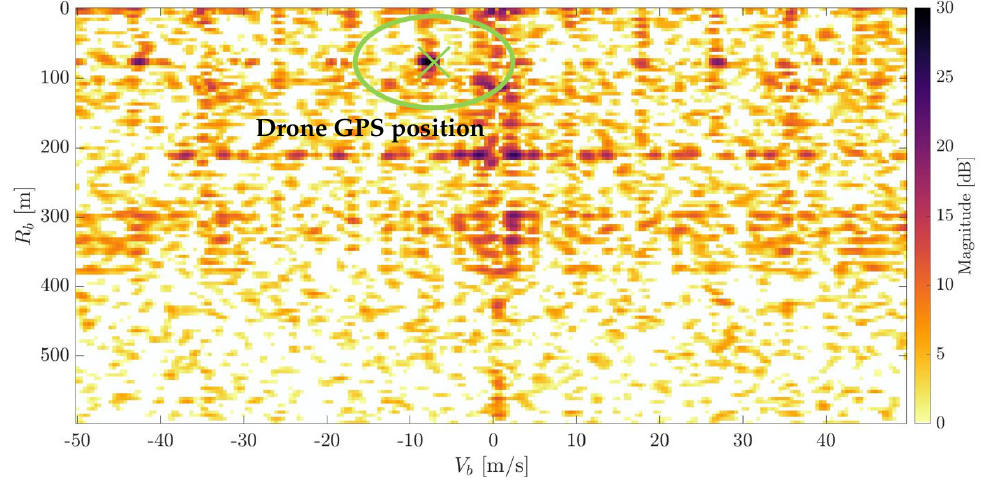
Figure 22. CAF with the drone detection ( T int = 100 ms) with reference to its GPS position (green